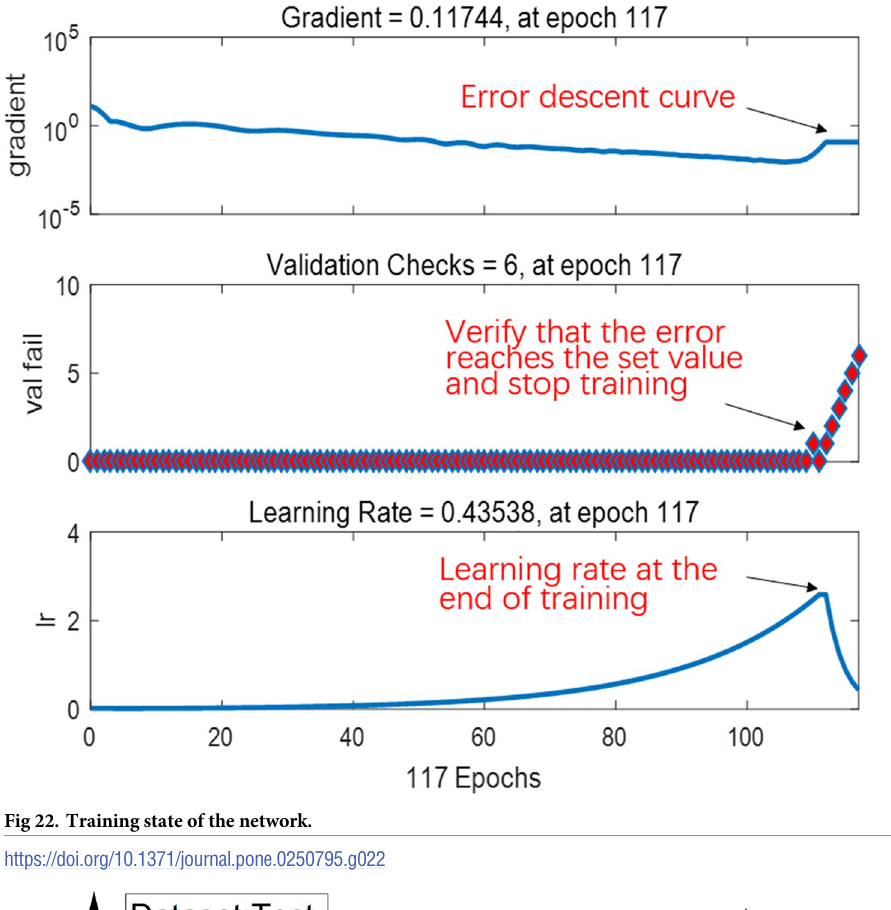
Fig 22. Training state of the network.